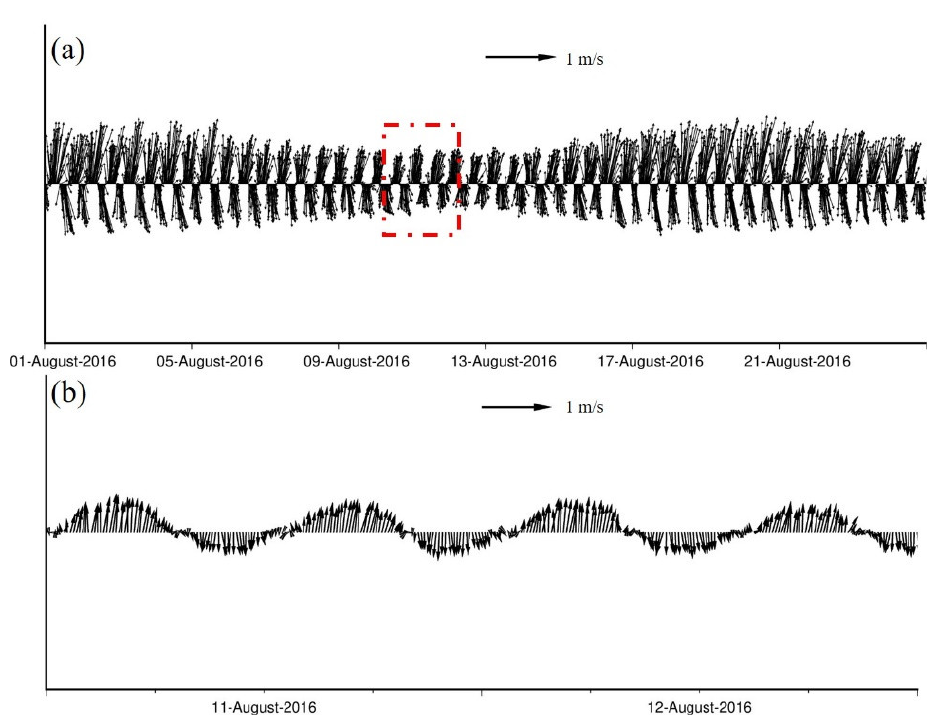
Figure 6. Local flow fields indicate that tidal currents predominantly vary with fortnightly amplitude modulation ( a ) approximately flowing northward during flood tides and southward during ebb tides. ( b ) The close-up of the current speed (marked with red dashed line in ( a )) exhibits that the semidiurnal tide dominates in the region.